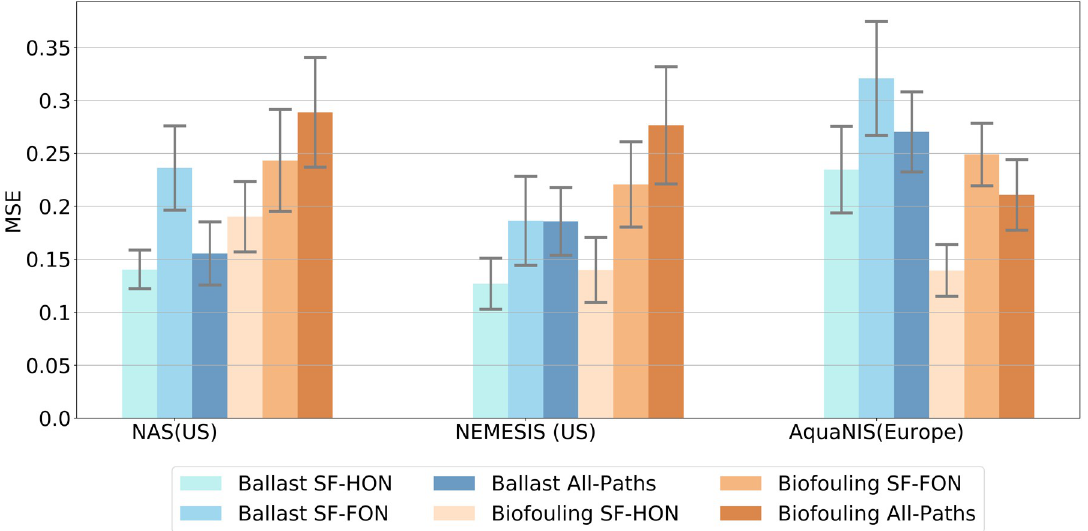
Fig 7. Validation results on the three data sets available. Comparison of the SF-HONs versus SF-FONs and All-Paths models shows that SF-HONs have generally ballast SF-HON yields lower MSE (suggesting more accurate results) on the NAS and NEMESIS datasets, while biofouling SF-HON yields lower MSE (more accurate results) on the AquaNIS data.